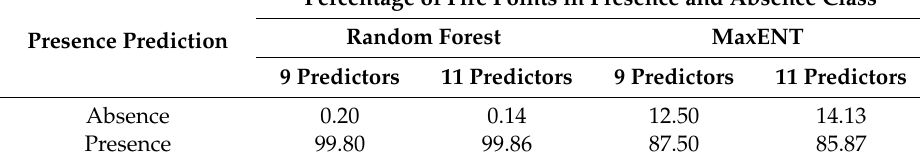
Table 4. Comparison of the di ff erent types of long-term wildfire presence prediction modeling methods in Yakutia (macroscale).